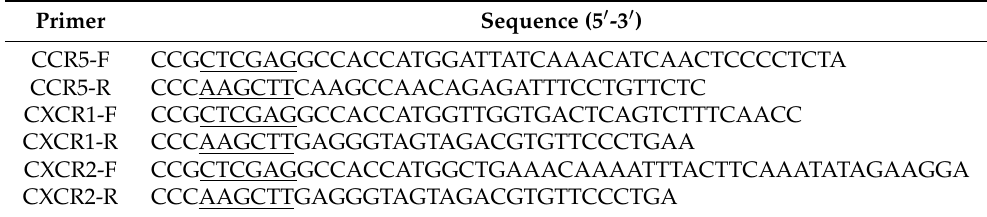
Table 4. The primers of chemokine receptor genes for